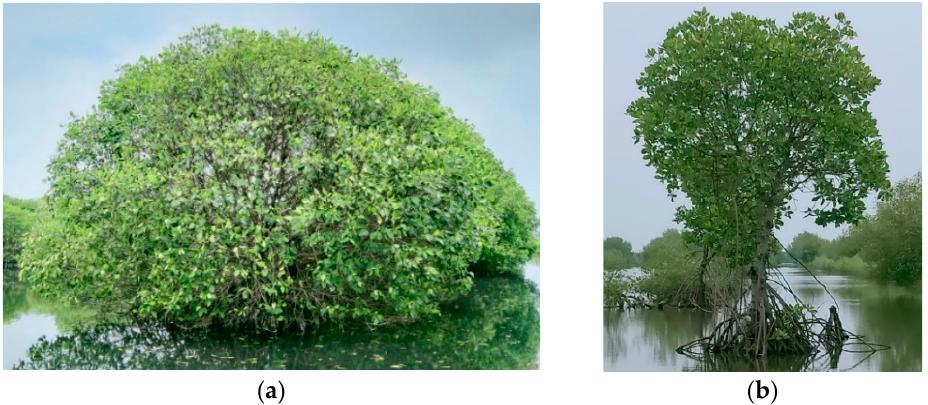
Figure 5. Mangrove tree species in the study area ( a ) Avicennia marina and ( b ) Rizhophora mucronata. Table 3. Carbon storage in four carbon pools in the study area.